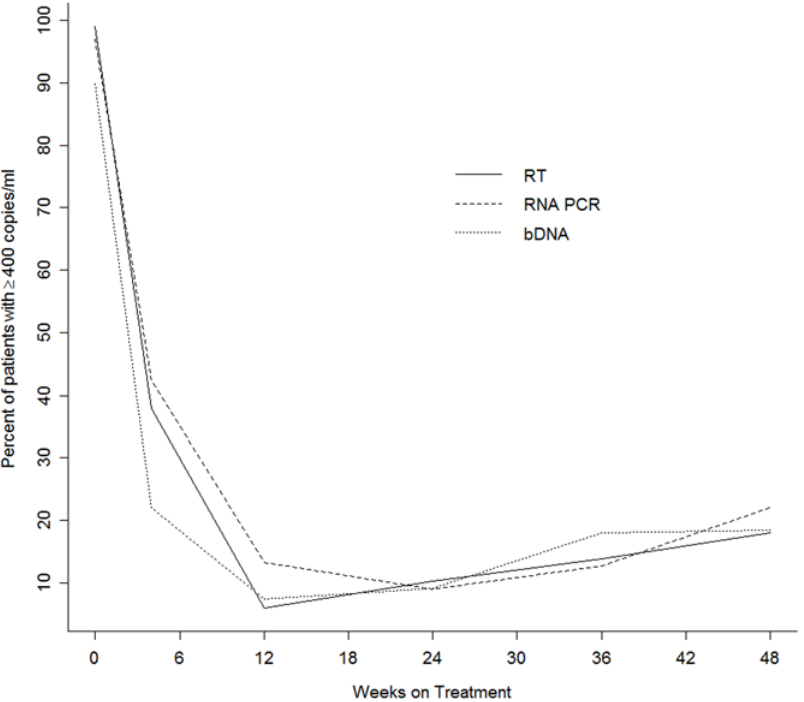
Figure 3. The proportion of patients with a detectable viral load ( $ 400 copies/ml) at study visits using three viral load assays (Cavidi reverse transcriptase (RT) assay, Roche RNA PCR, and branched DNA assay